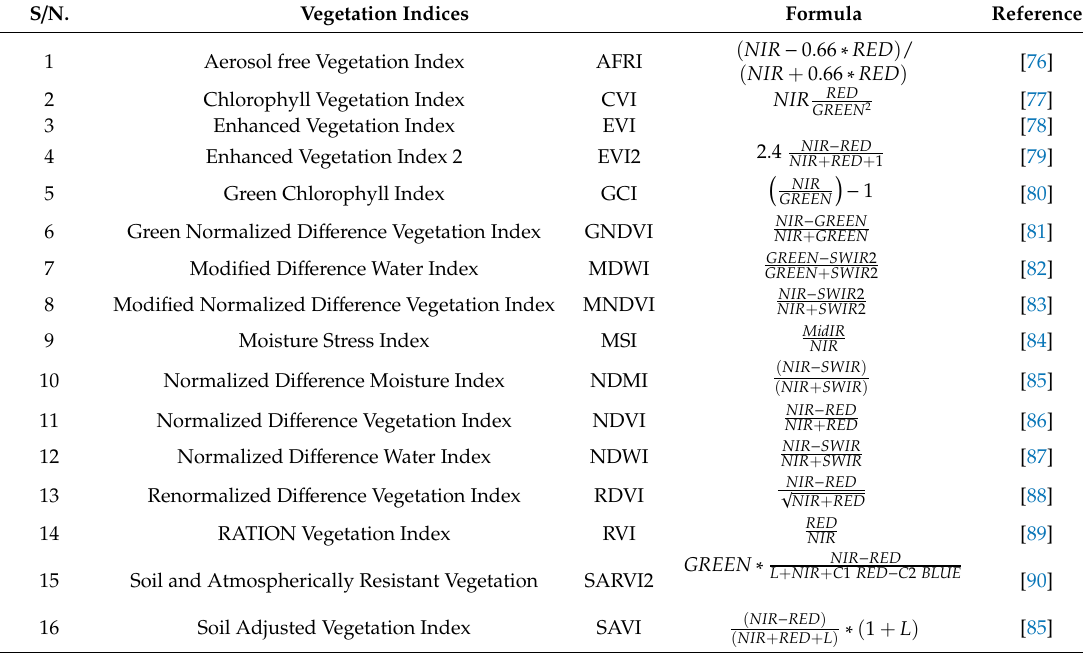
Table 4. Vegetation Health Indices for Impact and Recovery Analysis of Polluted and Nonpolluted Vegetation and Wetland.